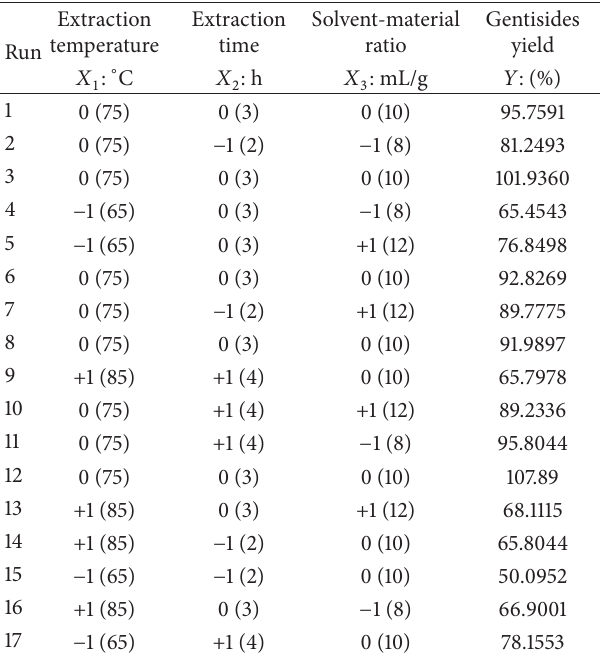
Table 1: Box-Behnken design and the actual and coded values of the independent